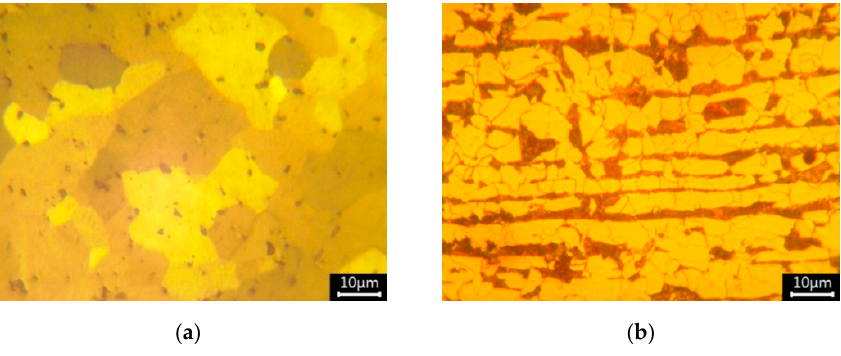
Figure 11. Microstructure of ( a ) AA5083 and ( b ) DH36.